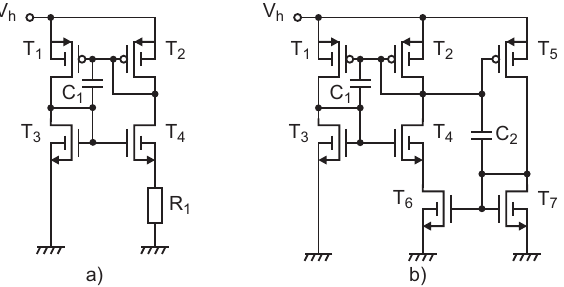
Figure 7. Examined subthreshold current sources: ( a ) with resistor [18] and ( b ) without resistor [17]. Table 1. Overview of the tested circuits.